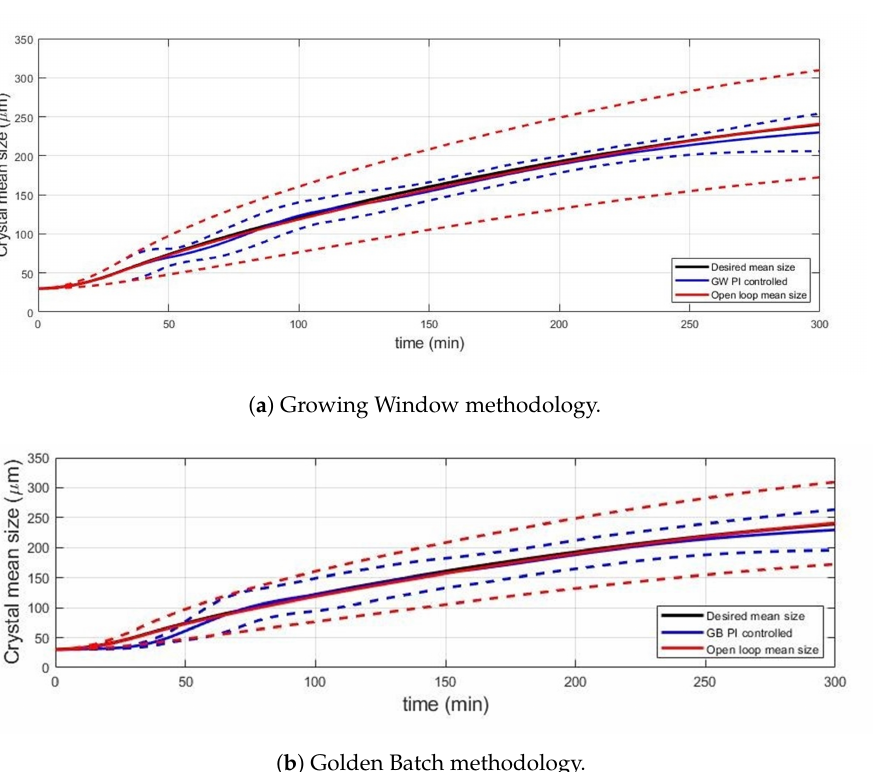
Figure 7. 95% confidence interval of controlled and open-loop cases obtained for the application of the different methodologies to the RBF soft sensor with Monte Carlo sampling disturbances (300 LHS samples